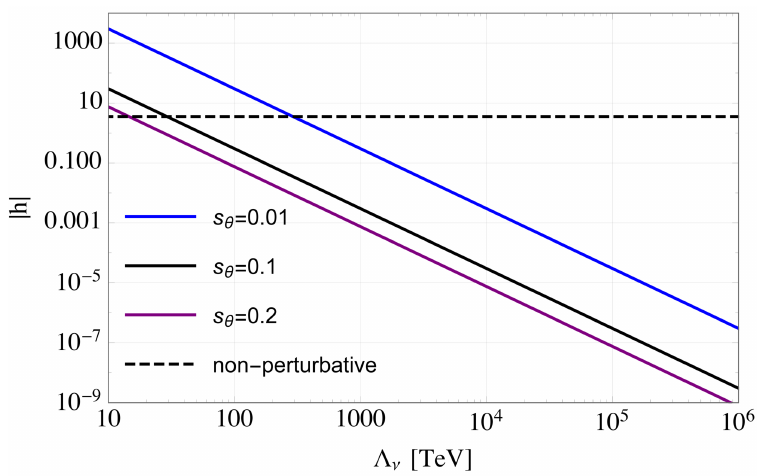
Figure 6 . The Yukawa couplings | h | for varying UV scale Λ ν in eq. (3.22) for s θ = 0 . 01 , 0 . 10 , 0 . 20 . The dashed line represents the upper limit for perturbative couplings, | h | .